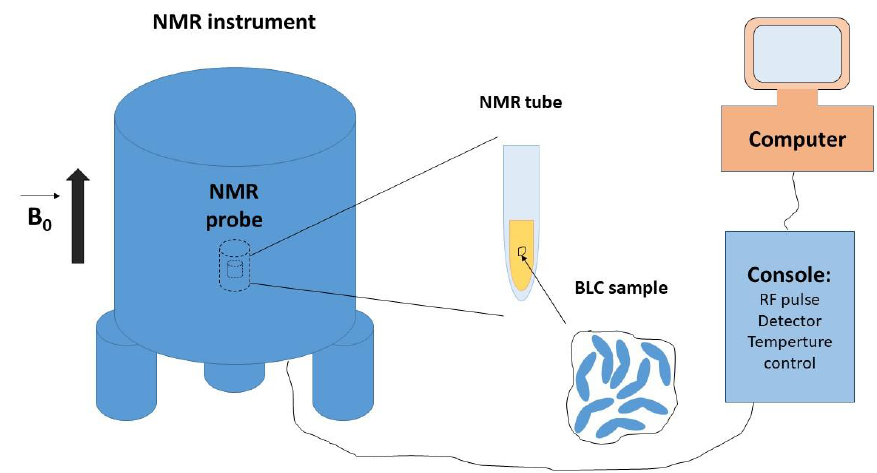
Figure 1. Experimental set-up for NMR measurements. The sample is introduced in a NMR tube, inside the NMR probe and aligned by the vertical magnetic field B 0 .